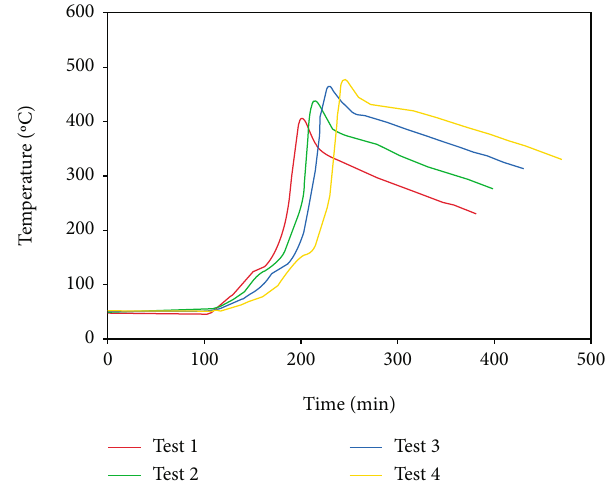
Figure 4: Temperature curves for sensor 8.